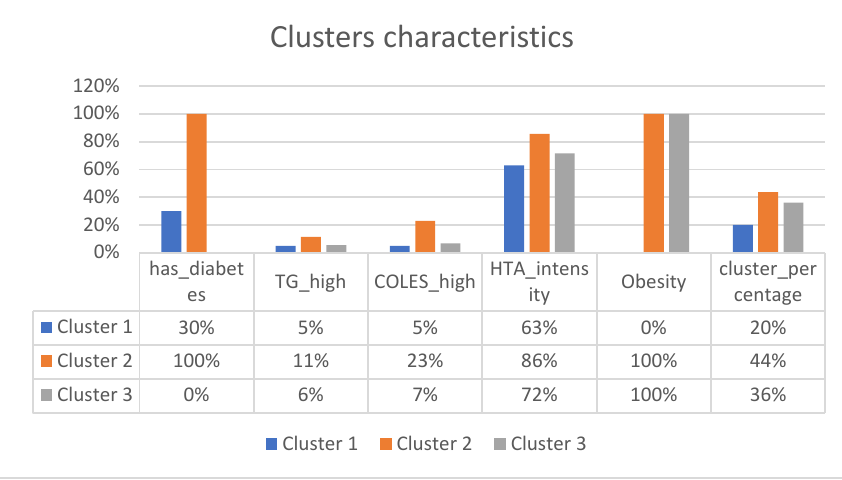
Figure 6. Clusters characteristics.